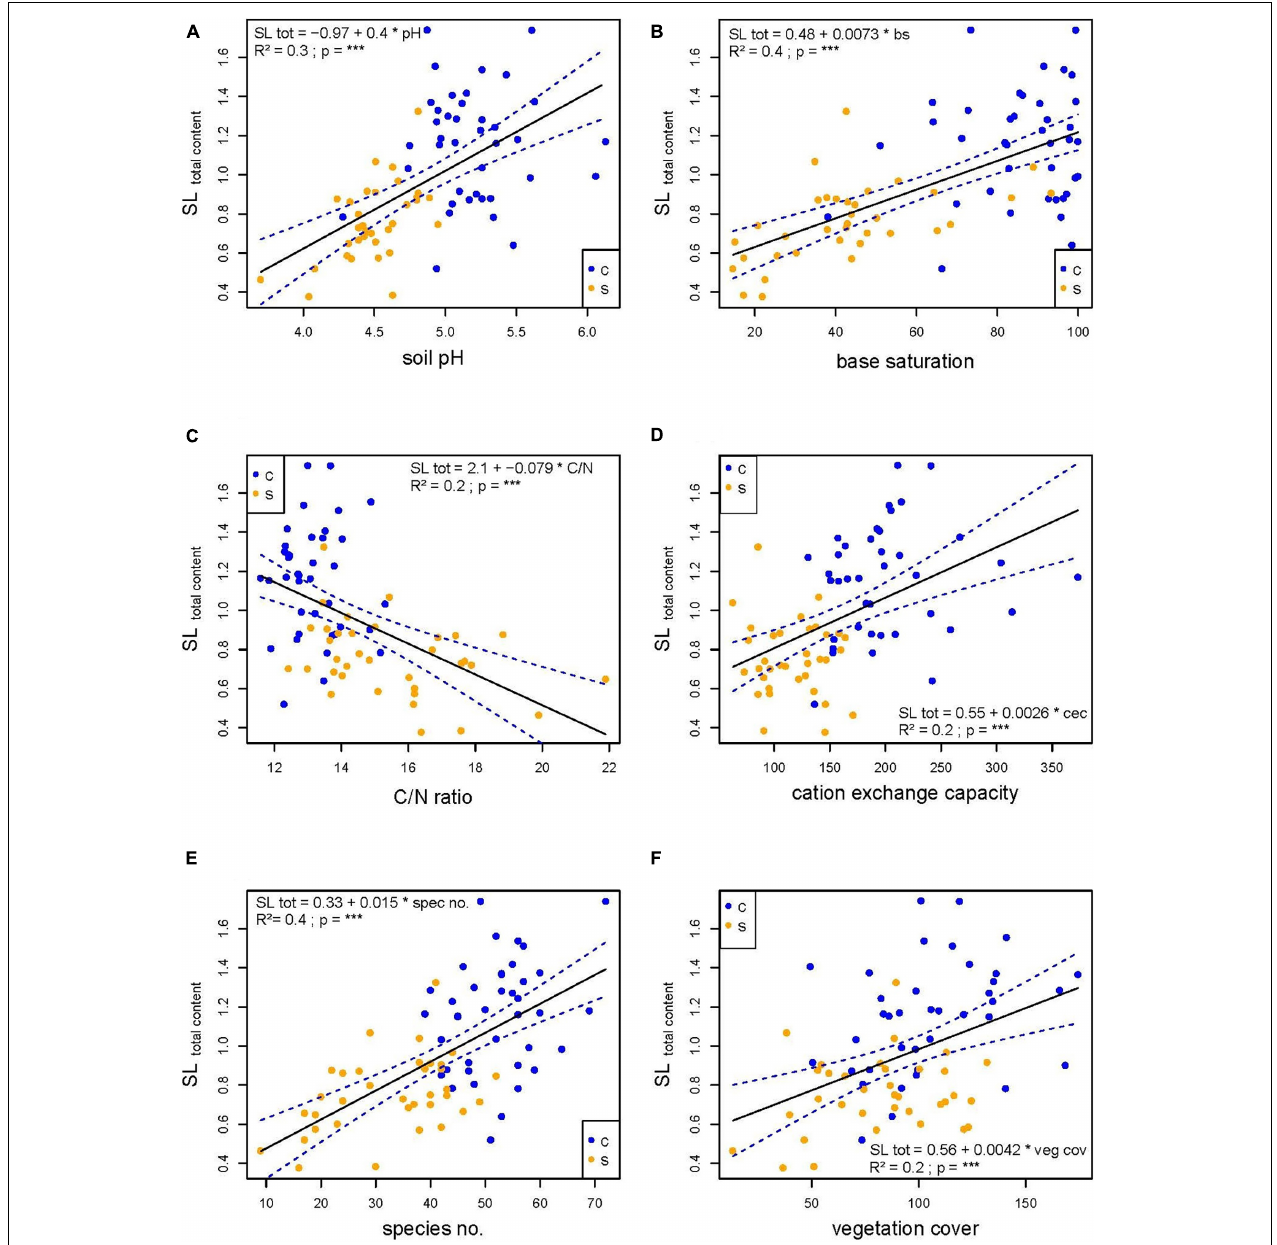
FIGURE 2 | Linear models of different environmental parameters [soil pH (A) ; base saturation (B) ; soil C/N (C) ; cation exchange capacity (D) ; vascular plant species number (E) ; vegetation cover (F) ] and the total sesquiterpene lactone (SL) content (in mg g − 1 ). The samples from grasslands localities with calcareous parent rock (c) are given in blue and the samples from grassland localities with siliceous parent rock (s) in orange. The regression equation, the r-squared ( R 2 ), the p -value, and the 95% confidence band are given for each relationship. Level of significance is given (* p < 0.05; ** p < 0.01; *** p <